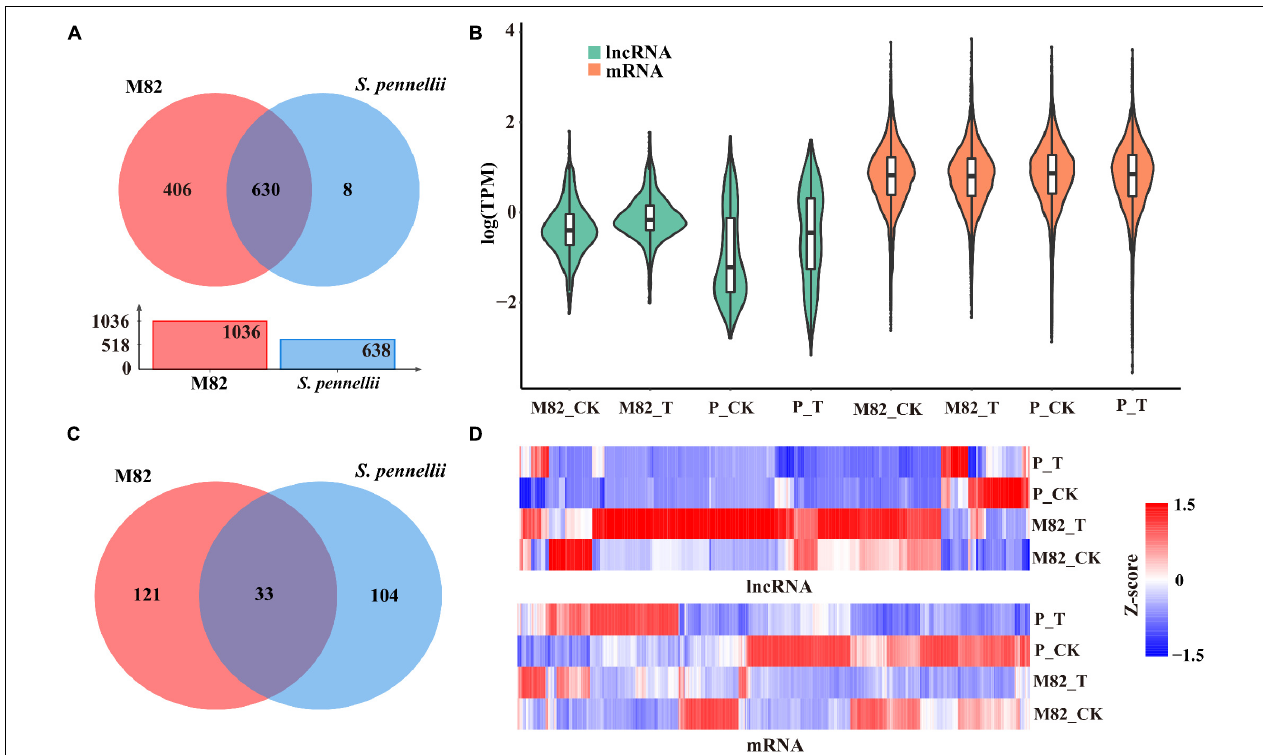
FIGURE 2 | Expression patterns analysis of lncRNAs and mRNAs. (A) Venn diagram of common and specific lncRNAs. Red represents M82, blue represents Solanum pennellii ( S. pennellii ). The overlap represents the lncRNAs that were expressed in both M82 and S. pennellii . The red bar and blue bar in the bar graph represent the number of lncRNAs that were expressed in M82 and S. pennellii , respectively. (B) Violin plot of expression levels for lncRNA and mRNA transcripts (showed in the relative expression level of mRNA/lncRNA presented by log-transformed). (C) The Venn diagram shows significant DE-lncRNAs ( P -value < 0.05). Overlaps represent the lncRNAs that were differentially expressed in both M82 and S. pennellii . (D) Heatmap presentation of relative expression levels of differentially expressed lncRNAs and mRNAs. Z -score represents the regulation trends, red represents up-regulation, blue represents down-regulation. The color scale bar shows z -score values after z -score row